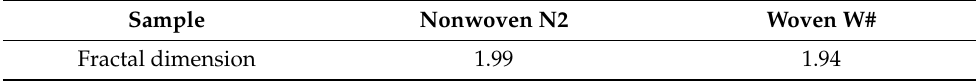
Table 4. Average fractal dimensions of samples.